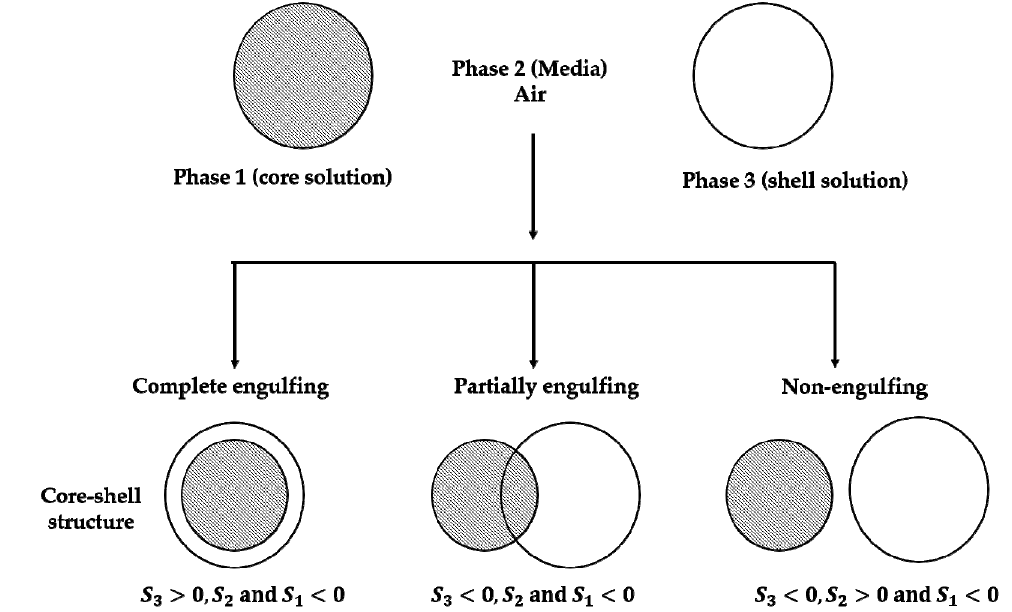
Figure 4. Prediction of microencapsulation configuration based on spreading coefficients.